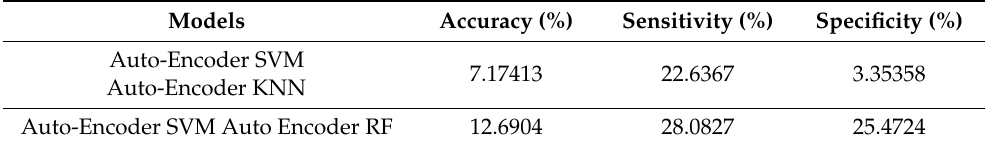
Table 5. Accuracy, sensitivity, and specificity Improvement in percentage .